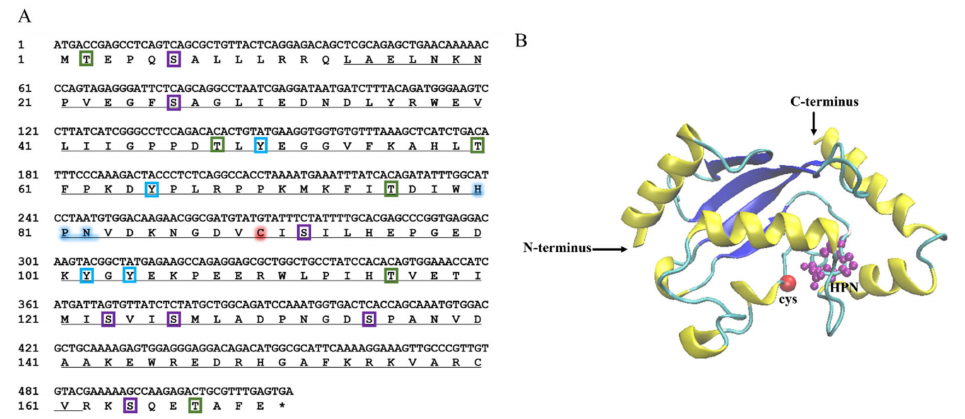
Figure 1. LcUbe2g1 gene sequence and the tertiary structure of Lc UBE2G1 protein. ( A ) The coding sequence of LcUbe2g1 and deduced amino acid sequence. The stop codons were indicated with asterisk (*), the UBCc (ubiquitin-conjugating catalytic) domain fold was underlined, the blue shade indicate the ubiquitin (Ub) binding motifs (HPN), the red shade indicate the active site cysteine (C), the purple boxes indicate the Ser phosphorylation sites, the green boxes indicate Thr phosphorylation sites and the blue boxes indicate Tyr phosphorylation sites; ( B ) Tertiary structure of Lc UBE2G1 protein. Lc UBE2G1 contains a UBC core catalytic domain consisting of 4 α helices and 4 β sheets, the purple spheres represent a conserved HPN pattern (His81, Pro82, Asn83) and the red spheres indicate a cysteine (Cys91) active site.